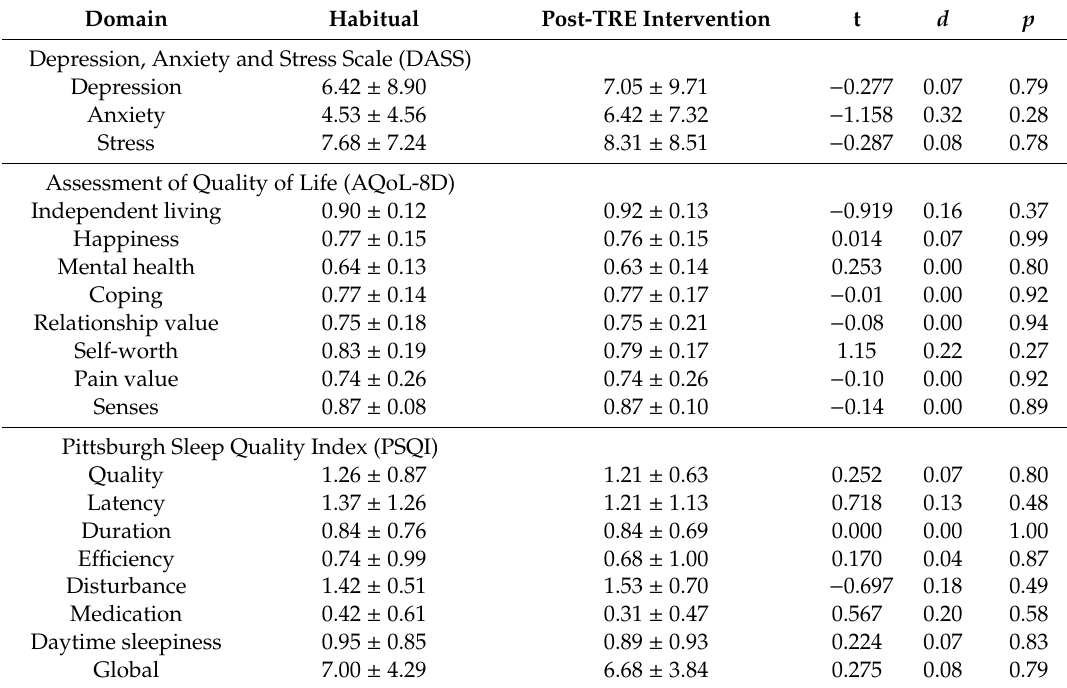
Table 7. Mean di ff erences between outcome scores of the DASS, AQoL, PSQI, CBB, EDE-Q and CIA at Habitual and post-TRE intervention time